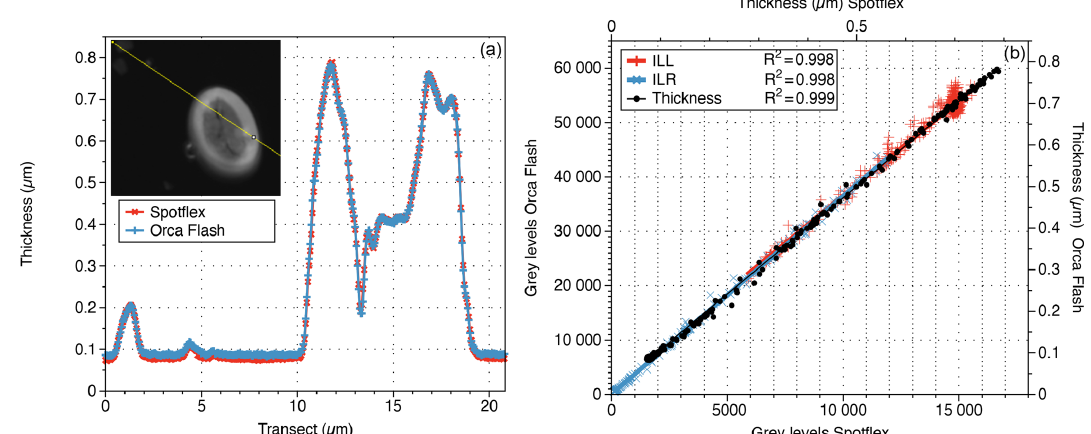
Figure 5. (a) Thickness along a transect (yellow line in the inset) measured with the SPOT flex (red line with crosses) and the ORCA-Flash cameras (blue line with plus signs). (b) Relation between I LL (red), I LR (blue) and thickness (black) measurements made by the two cameras along the same transect.